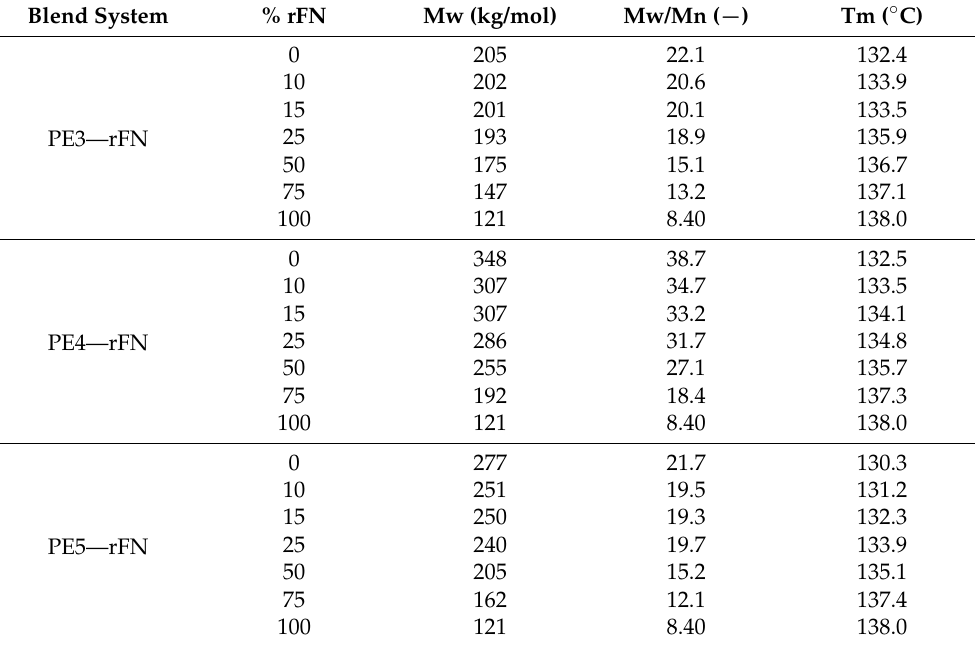
Table 3. GPC and DSC results for PE3—rFN, PE4—rFN and PE5—rFN blend systems. Blend